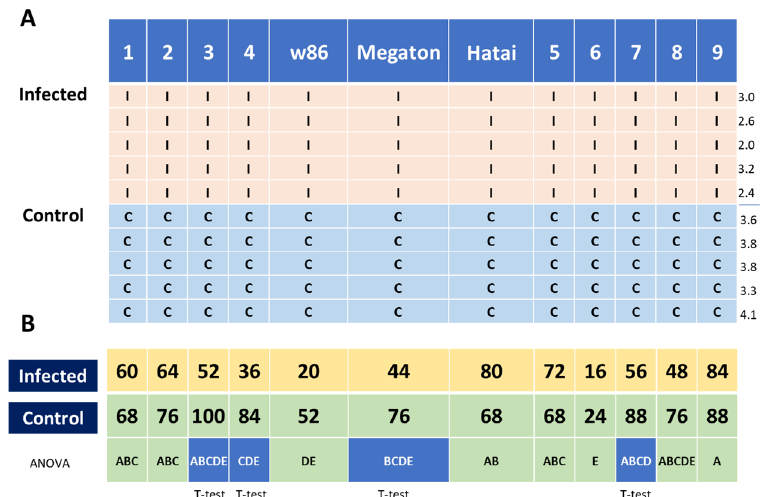
Figure 3. Experiment map ( A ) and above-soil surface appearance evaluation ( B ) in the pots assay under semi-field conditions. The maize cultivars tested are detailed in Table 1. In the experiment map ( A ), the bottom of the scheme faces north. Pink rows are local farm soil inoculated with M. maydis (I). Blue rows are control—the same soil without additional infection (C). The numbers on the right are the average sprouts’ emergence in the row, from east to south (per pot out of five seeds). They show that if it exists, a random effect of the experiment design has a minor impact on the results. Sprout aboveground emergence results (( B ), average percentage per treatment) evaluated after 7 days after sowing. Different letters represent a significant difference ( p < 0.05) in an analysis of variance (ANOVA) assay. Blue cells differ significantly ( p < 0.05, t -test) from the control treatment in the same